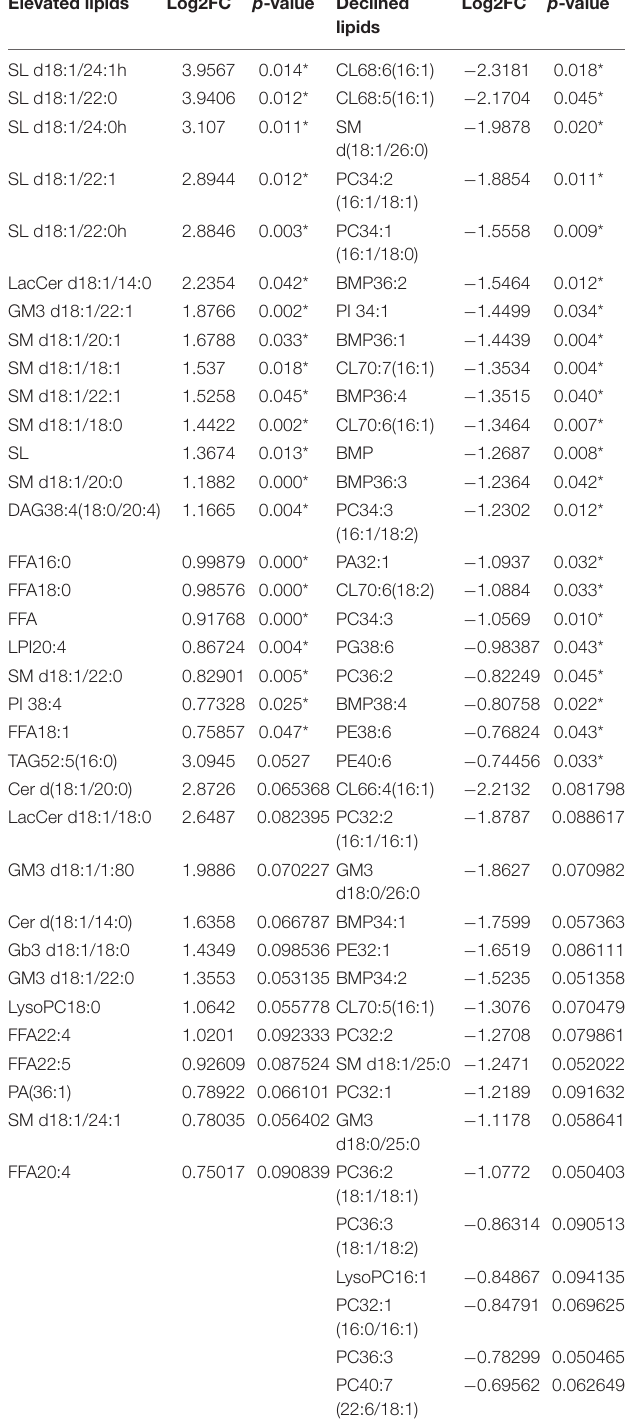
TABLE 1 | Differential lipids of basal and luminal subtype (basal vs. luminal). Elevated lipids Log2FC p -value Declined